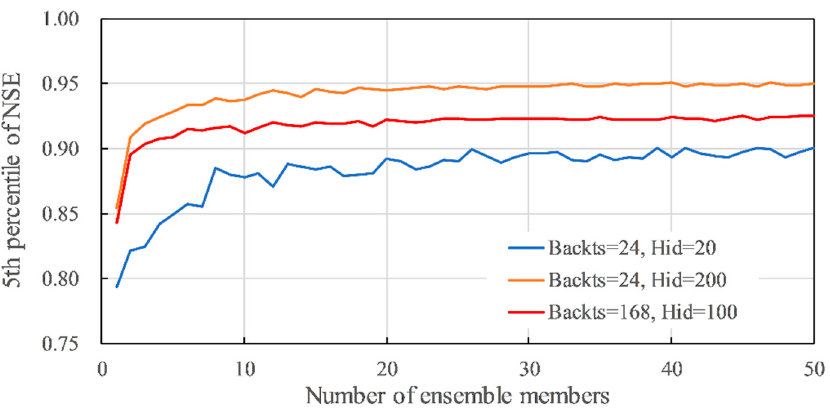
Figure 8. Examples of relationship between number of ensemble members ( N ) and 5th percentile of NSE for Case 2. Blue line: Back ts = 24, Hid = 20, Drp = 0, Drp r = 0; orange line: Back ts = 24, Hid = 200, Drp = 0, Drp r = 0; red line: Back ts = 168, Hid = 100, Drp = 0, Drp r = 0.